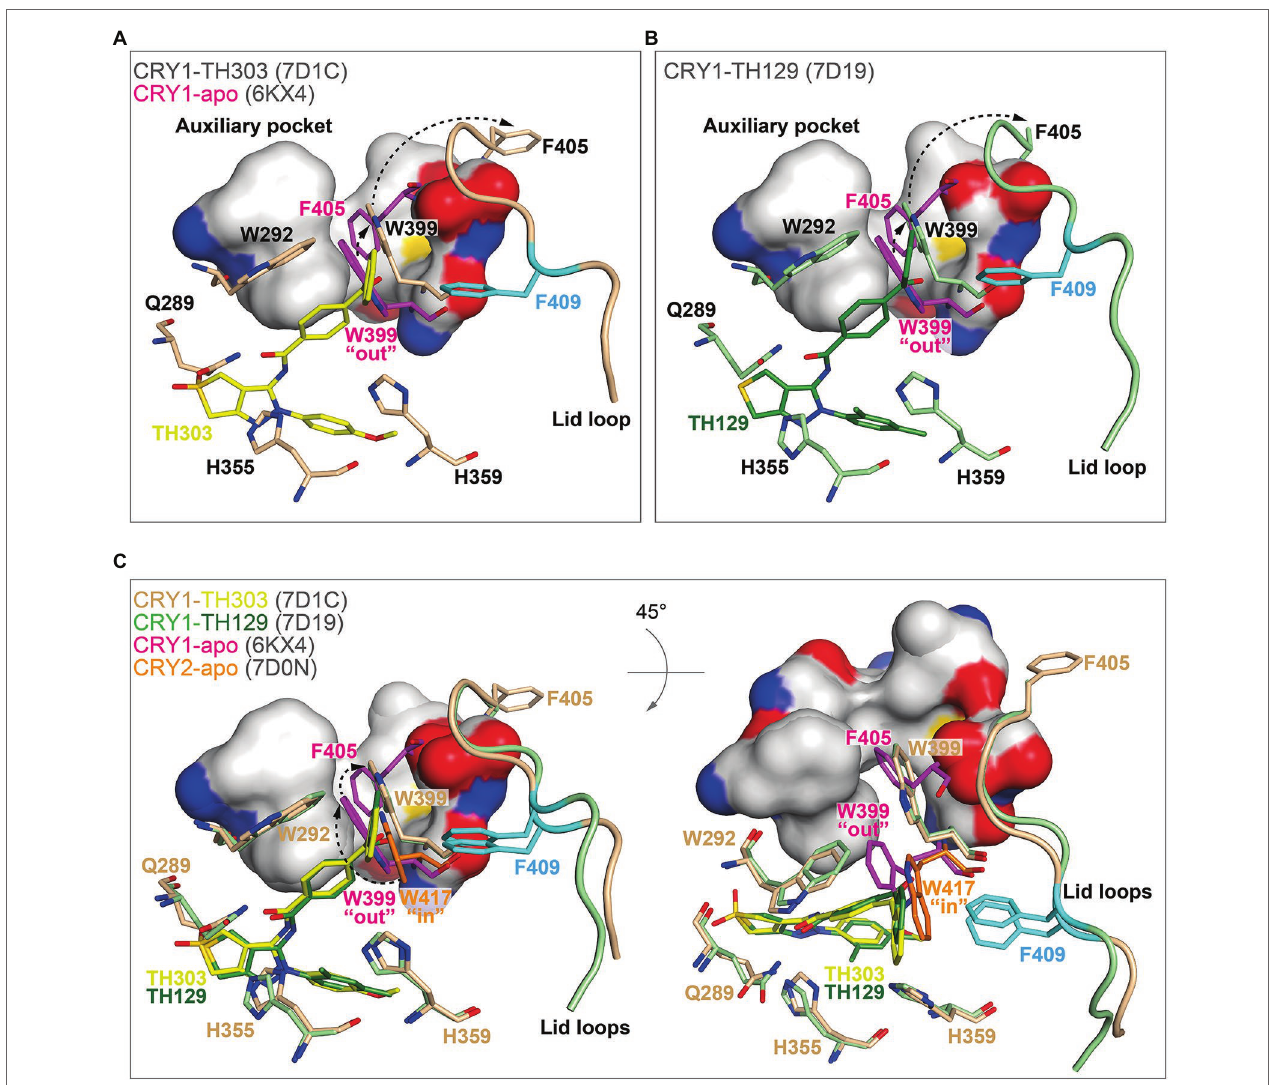
FIGURE 6 | The binding of benzophenone derivatives to CRY1 induced gatekeeper and lid loop reordering. (A,B) The benzophenone moieties of TH303 ( A , yellow, 7D1C) and TH129 ( B , green, 7D19) form a severe steric clash with the intrinsic gatekeeper W399 “out” conformation of CRY1-apo (6KX4; magenta). Repositioning of W399 (beige and light green) into the auxiliary pocket (small arrow) induced steric overlap with F405 (intrinsically inserts into the auxiliary pocket), which relocated to a distal position (large arrow) causing rearrangement of the lid loop. The lid loop residue F409 (cyan) was repositioned to form a stacking interaction with the benzophenone. The surface is shown for the auxiliary pocket residues F295, F296, A299, F306, I314, M398, and S404. (C) Conformational isomerism of CRY1 and CRY2 gatekeepers may regulate TH303 and TH129 selectivity. Superposition of CRY2-apo (7D0N) gatekeeper W417 onto CRY1 crystal structures. The intrinsic CRY2 gatekeeper W417 “in” conformation would likely require two conformational changes to enter the auxiliary pocket (dotted arrows, left panel). A rotated view (45 ° around the X-axis) shows the large conformational change required for the gatekeeper to enter the auxiliary pocket (right panel), making it less energetically favorable in